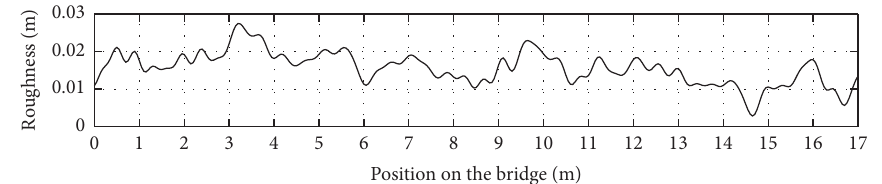
Figure 7: Sample of irregularity amplitude for road class